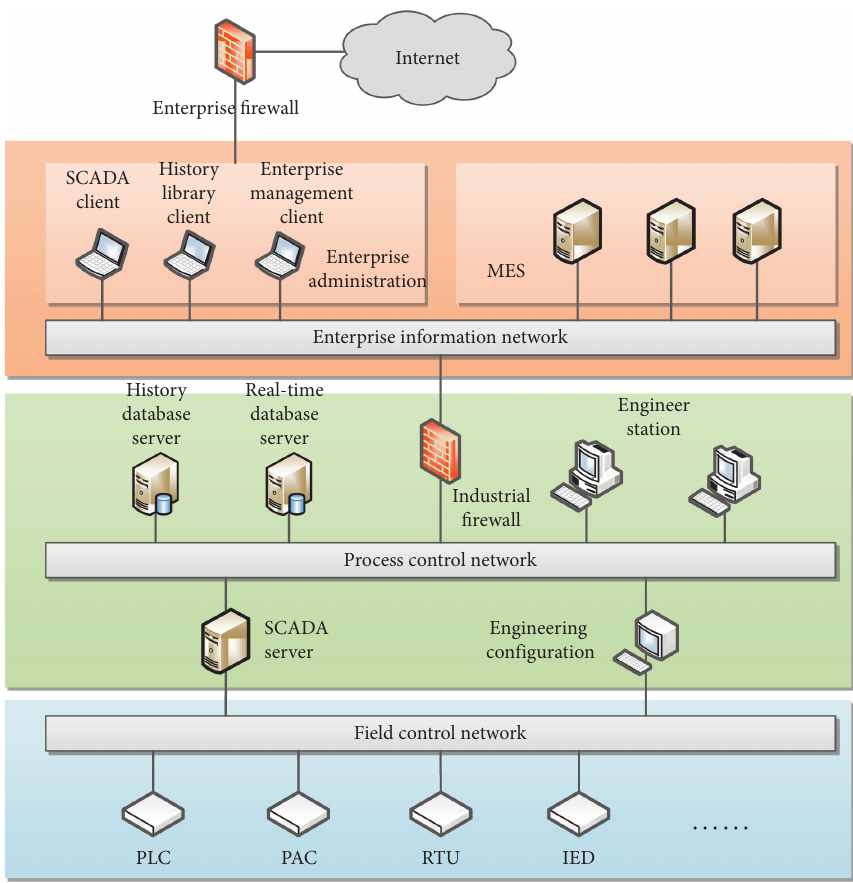
Figure 1: Industrial control system.